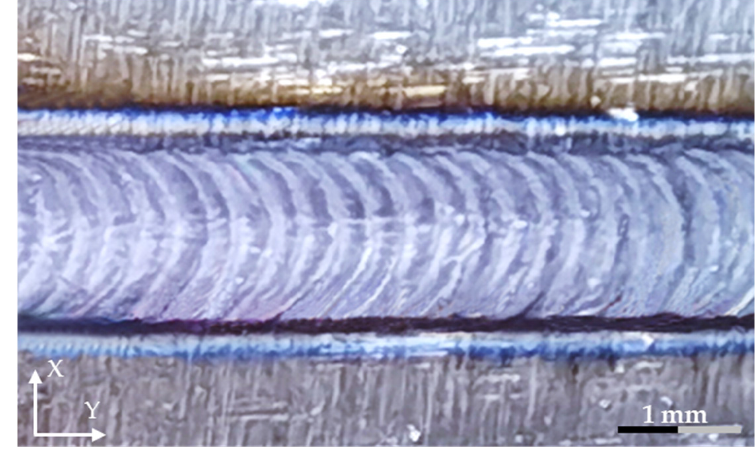
Figure 2. Overall macroscopic morphology of the weld joint (No. 3 sample).